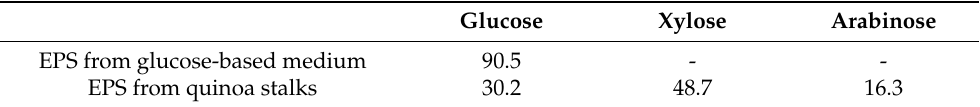
Table 3. Content of monosaccharides in the produced EPS, % ( w / w ).